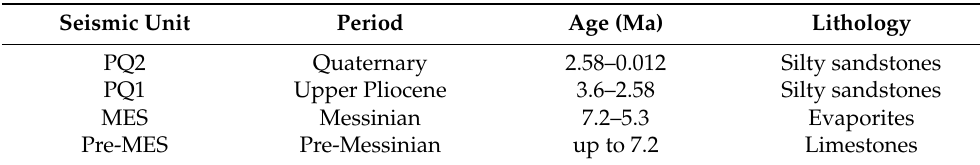
Table 1. Age and lithology of the seismic units occurring in the western Ionian area (from [57] and references